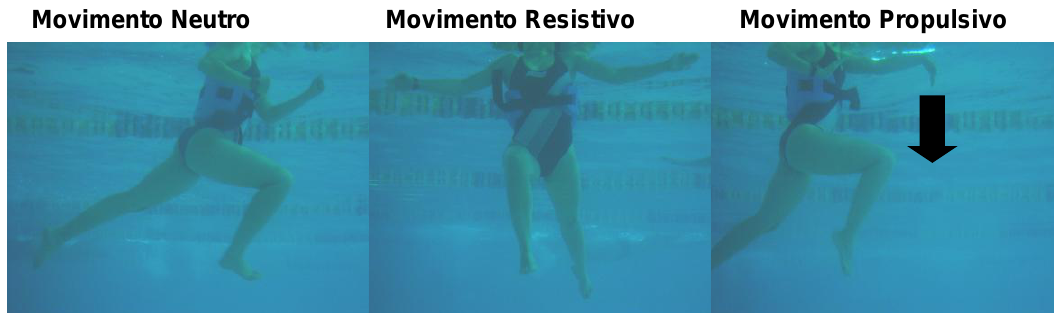
Figura 1. Foto ilustrativa dos diferentes movimentos de membros superiores.